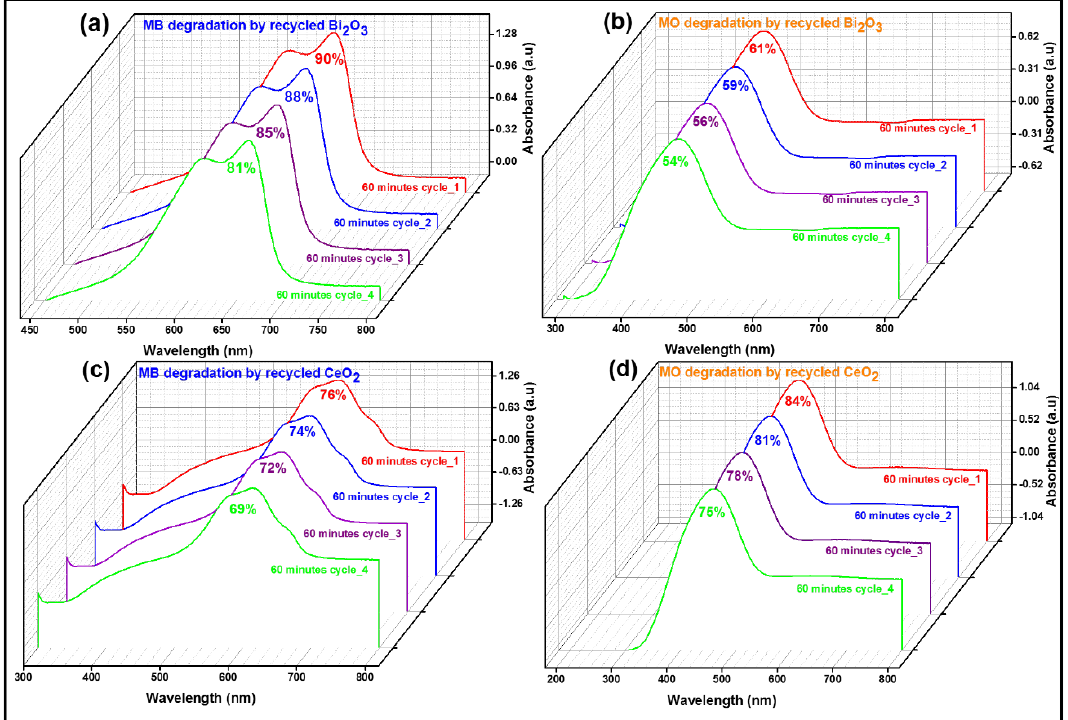
Figure 6. %Photoreduction in the absorption of MB and MO by recycled ( a , b ) Bi 2 O 3 and ( c , d ) CeO 2 under visible light.